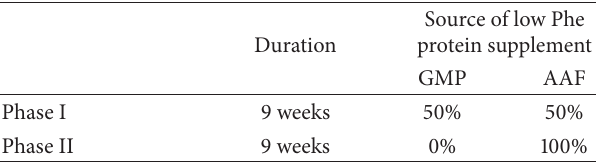
Table 1: The source of low Phenylalanine (low Phe) diet during the phases of the